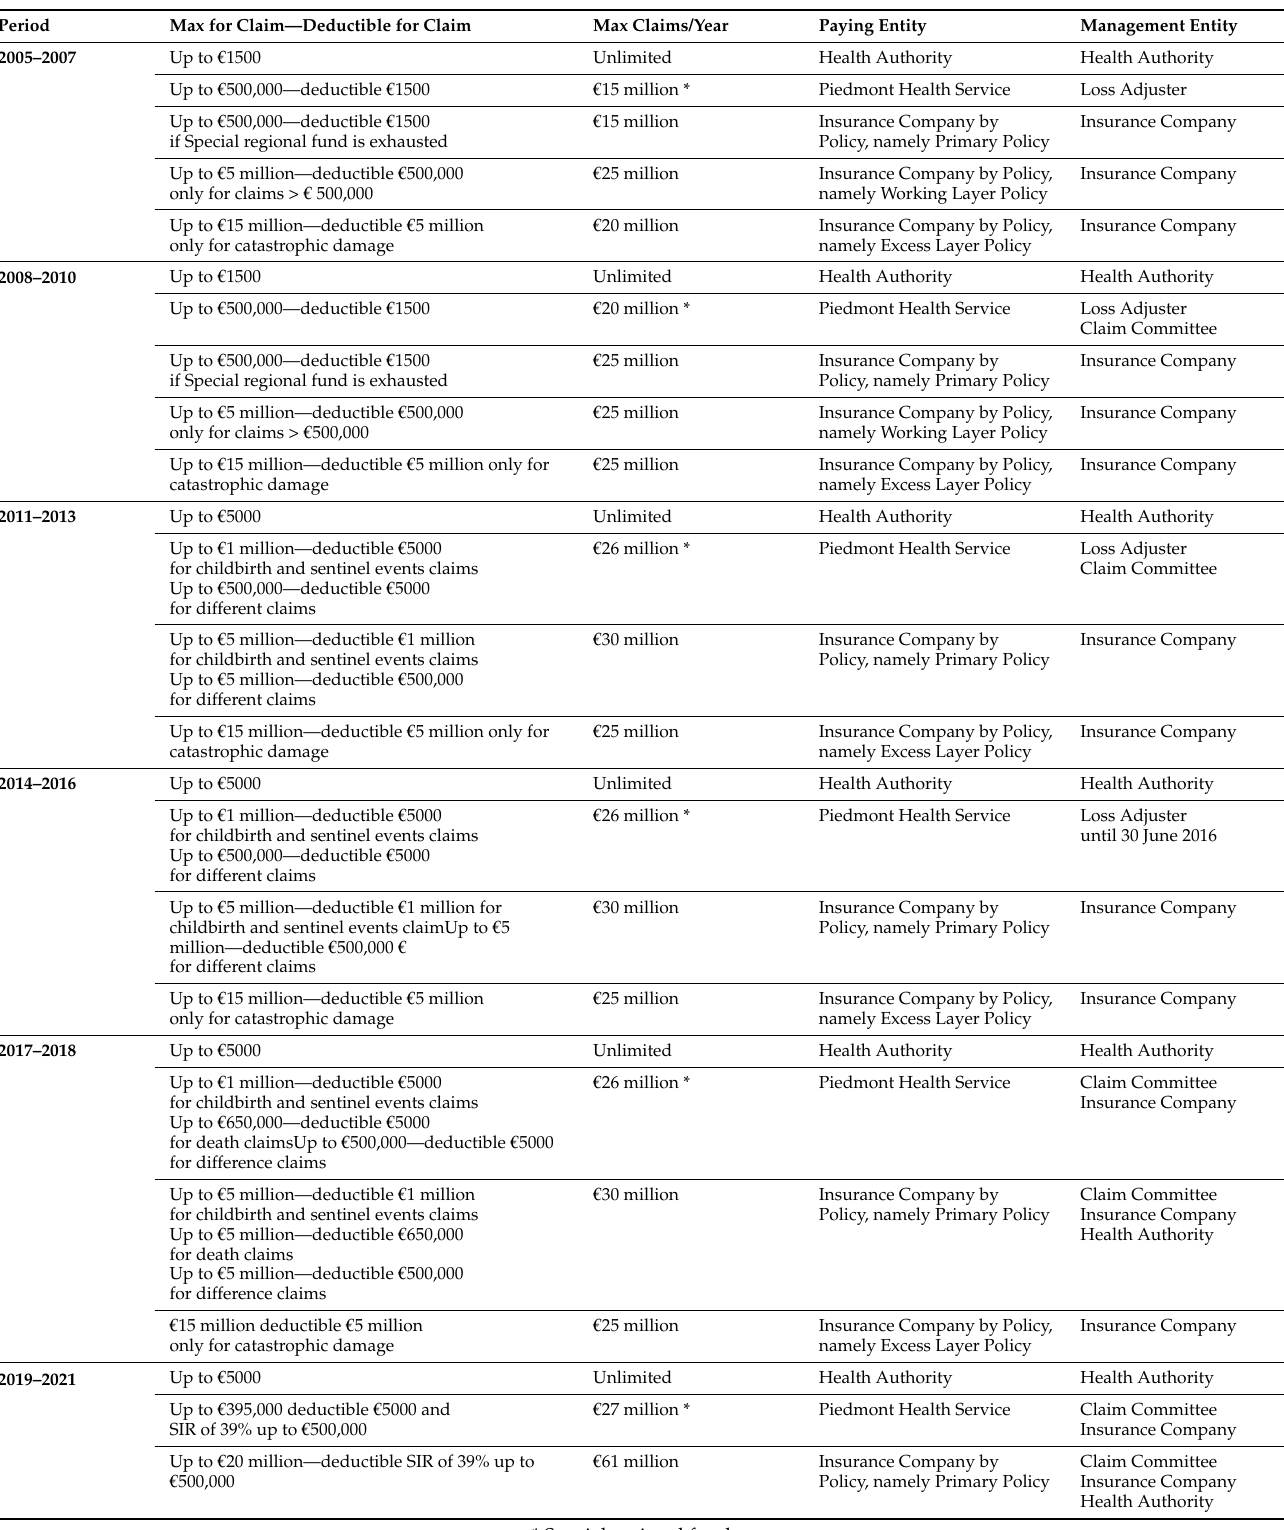
Table 5. Mixed models adopted by the Piedmont Health Service from 2005 to